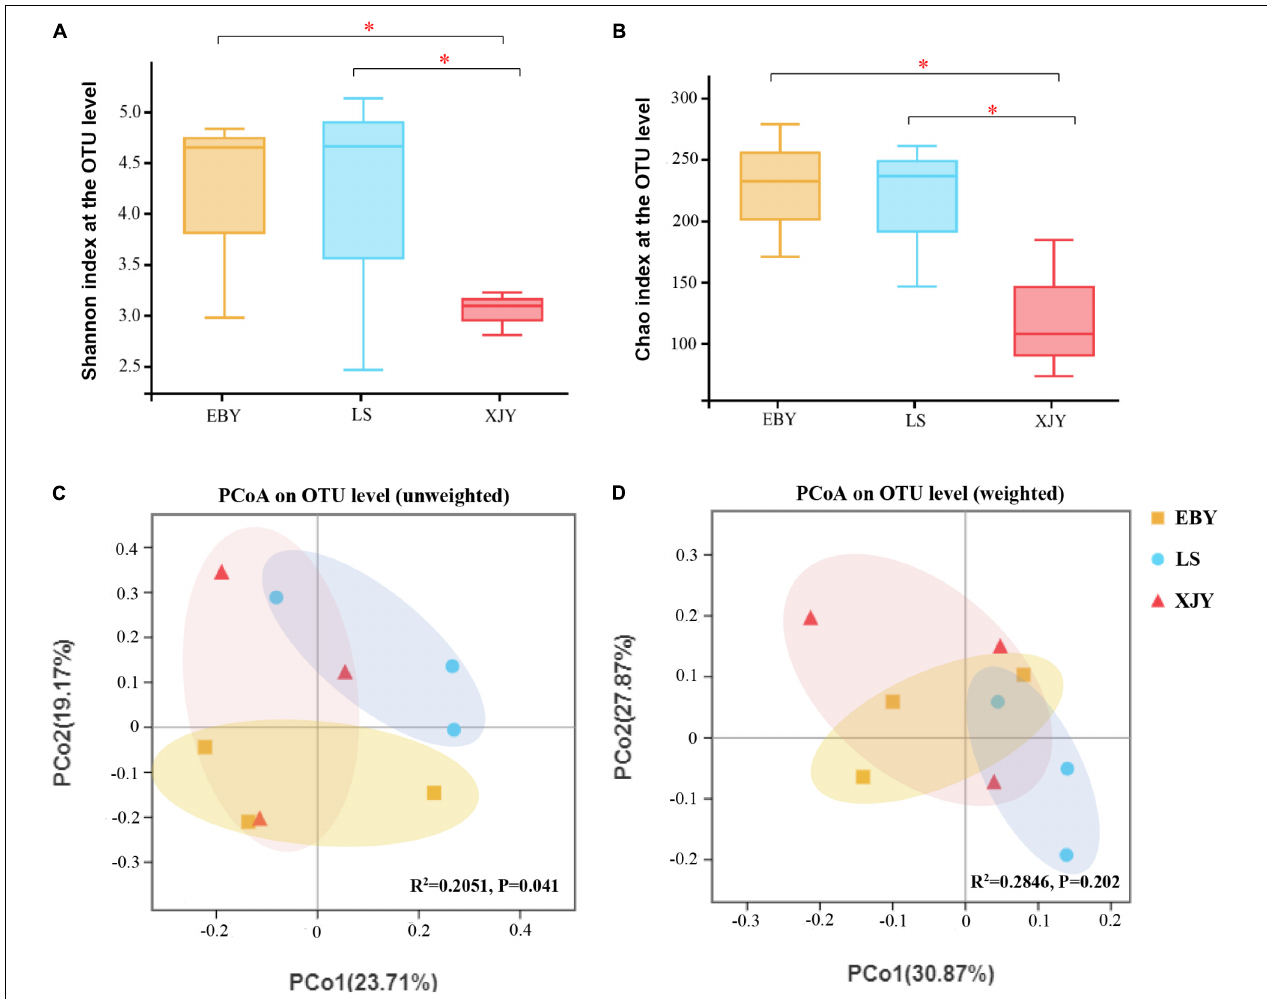
FIGURE 4 | Fungal communities in the A. glabripennis larval gut. Boxplots of (A) species diversity (Shannon index) and (B) species richness (Chao index). Significant differences in alpha-diversity were analyzed by Wilcoxon rank-sum test ( ∗ 0.01 < p ≤ 0.05). (C) Unweighted and (D) weighted UniFrac-based PCoA plots of fungal communities. The significant differences in beta-diversities were analyzed using adonis analysis with 1,000 Monte Carlo permutations. EBY, Populus gansuensis ; LS, Salix babylonica ; XJY, Populus alba var. pyramidalis